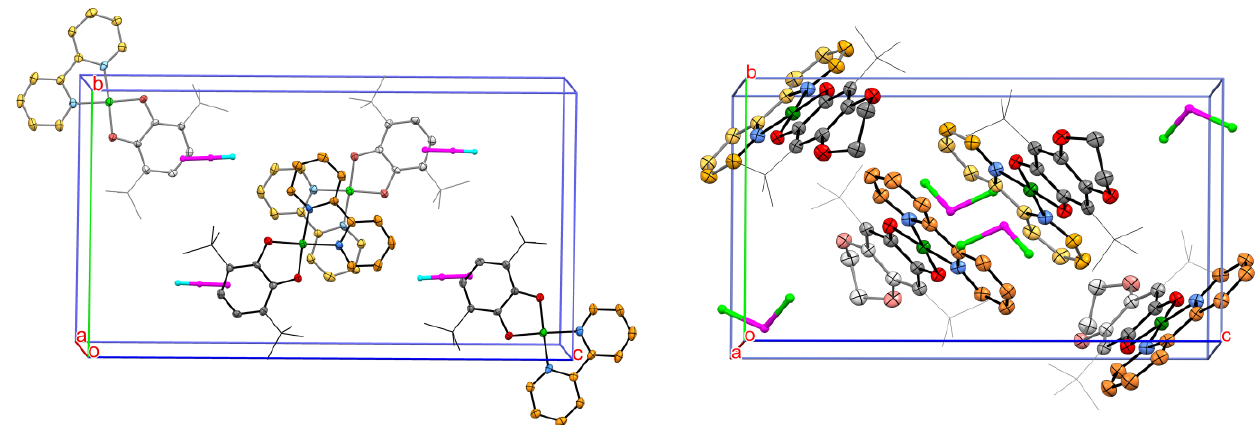
Figure 2. Views of unit cells of 1 (left) and 2 (right) with 50% thermal probability ellipsoids. Hydrogen atoms are omitted for clarity. Carbon atoms of diimines are orange-colored.